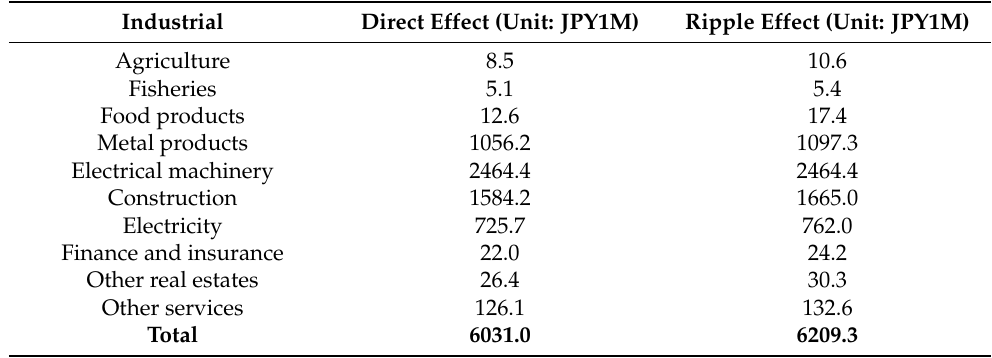
Table 9. Economic ripple effects of installing AVSs.